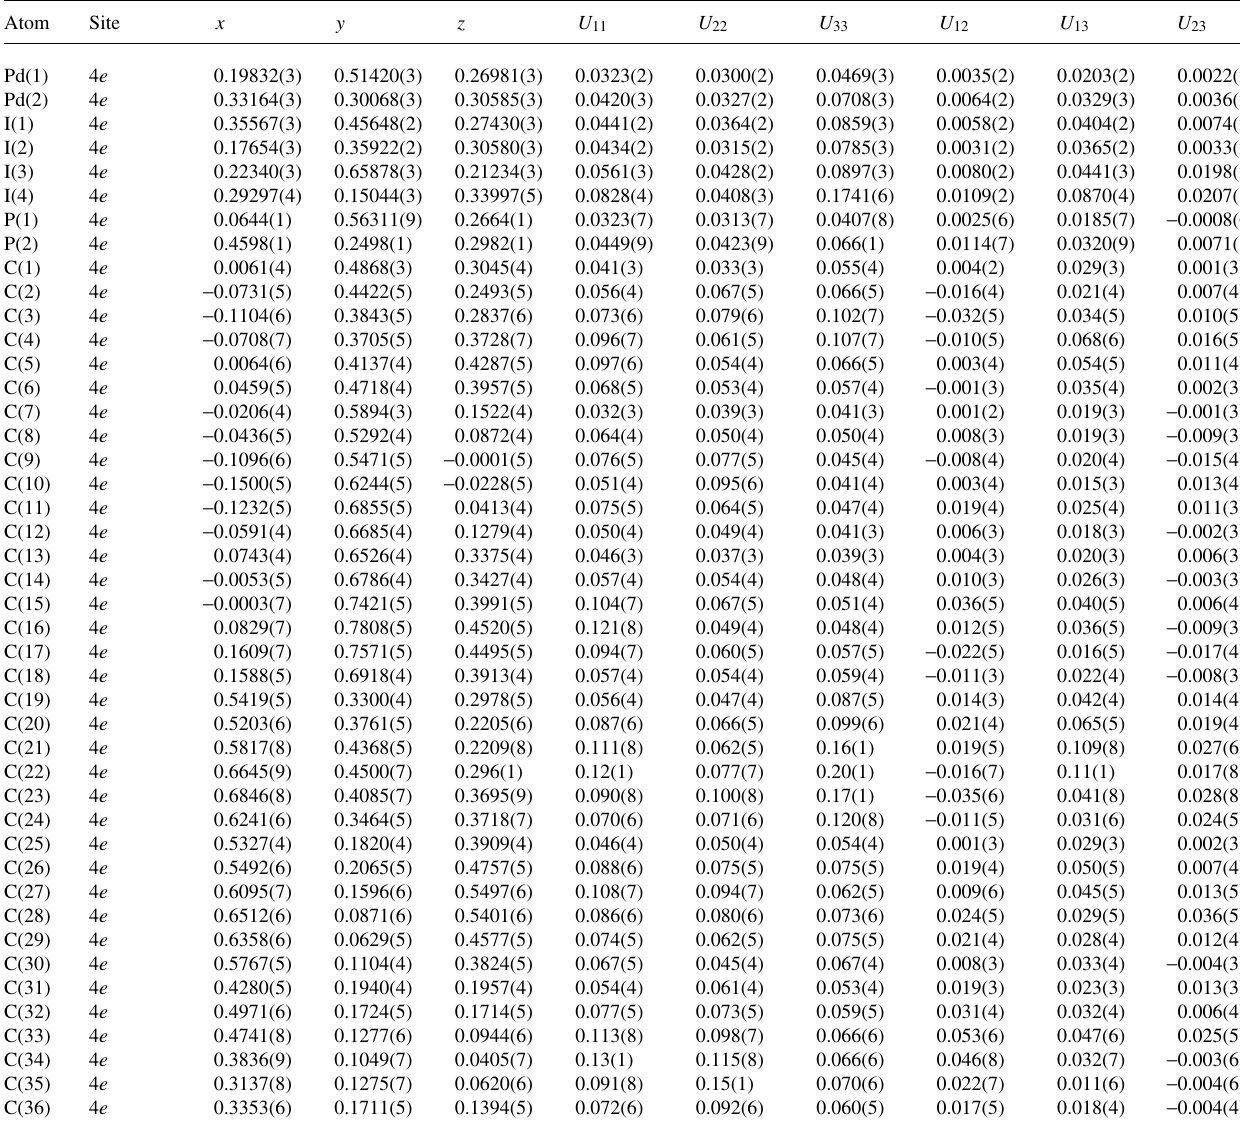
Table 3. Atomic coordinates and displacement parameters (in Å 2 )